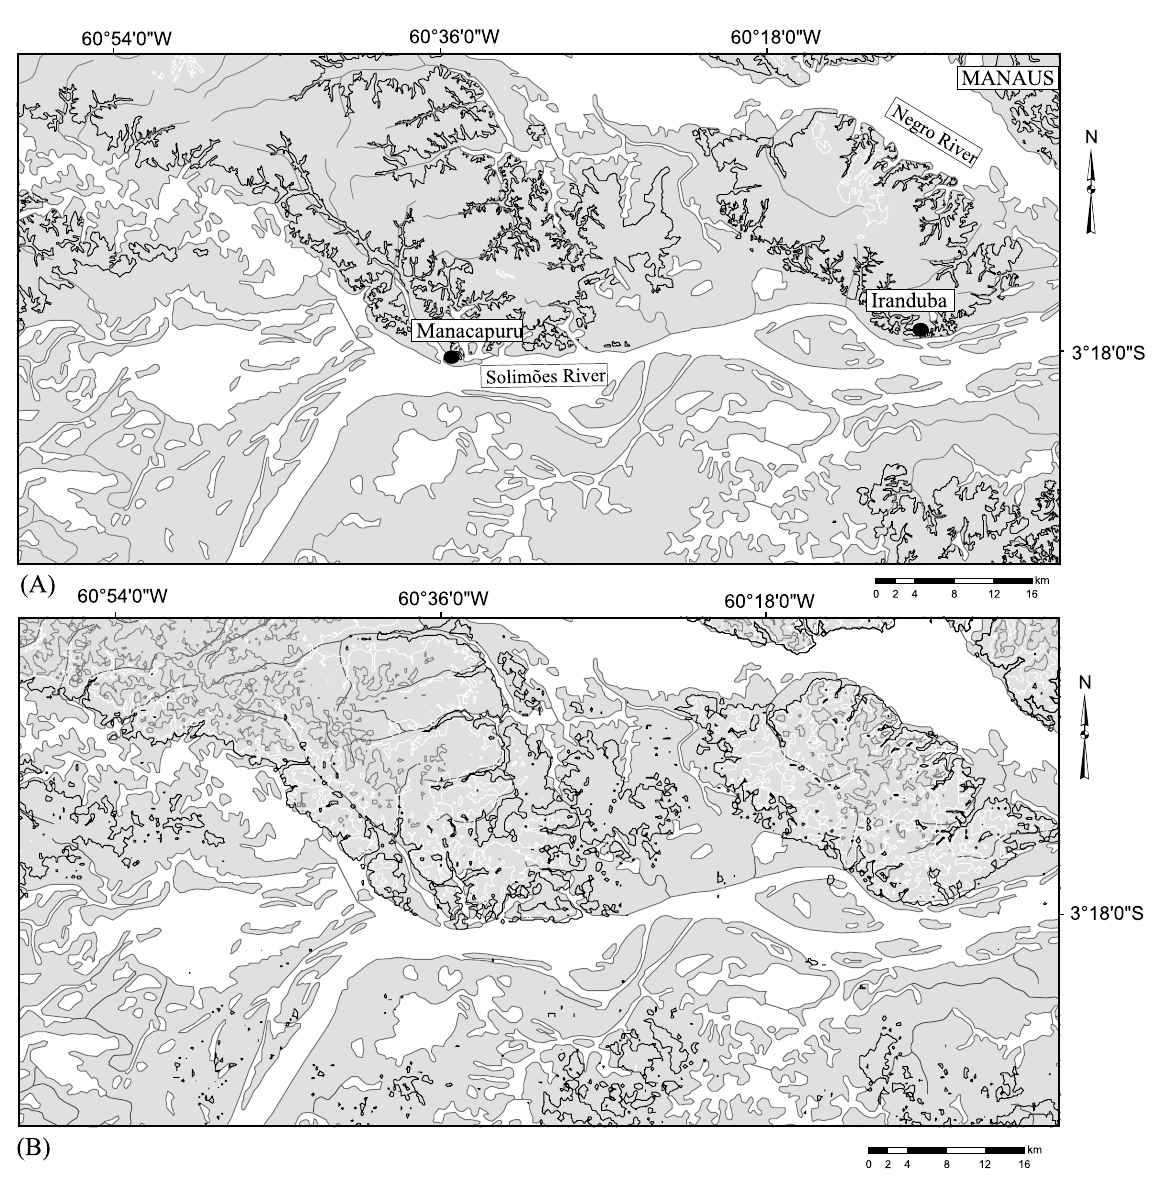
Fig. 2 – Comparison between topographical contour lines obtained from the 1:100.000 topographic charts (A) and those from the SRTM model (B). Contour lines of the topographic charts are at 50 m and 100 m and the ones from the SRTM model are at 35 m, 50 m and 70 m represented in black, white and gray lines,